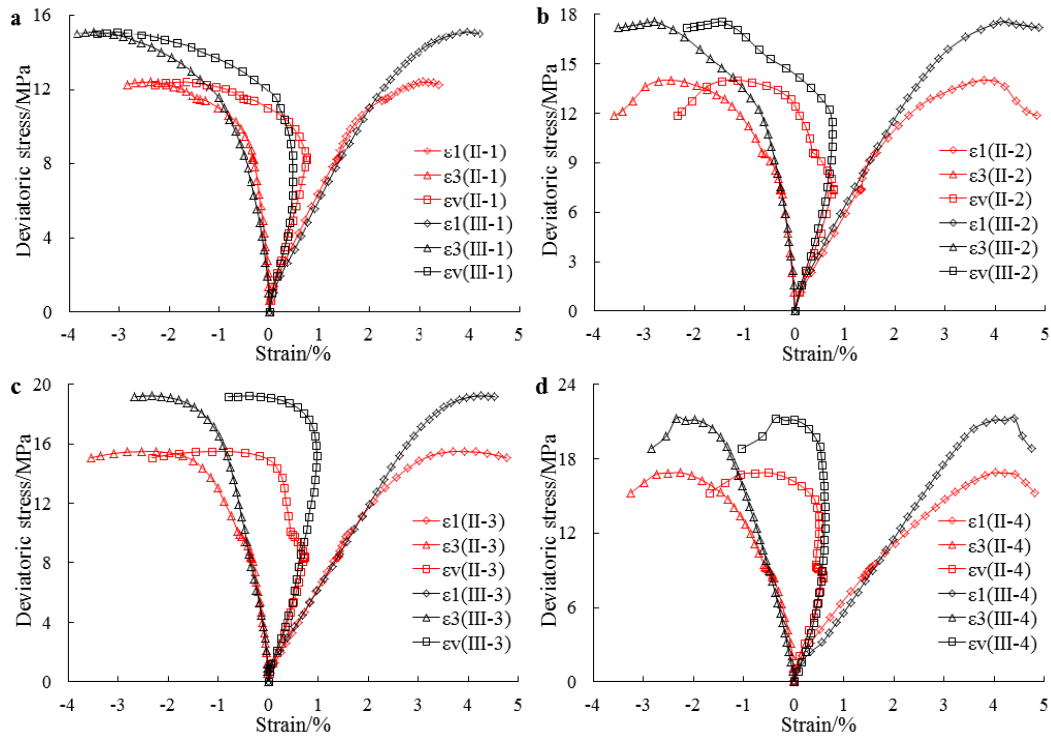
Figure 9. Stress–strain of the coal specimens: ( a ) for coal II-1 and III-1; ( b ) for coal II-2 and III-2; ( c ) for coal II-3 and III-3; ( d ) for coal II-4 and III-4.